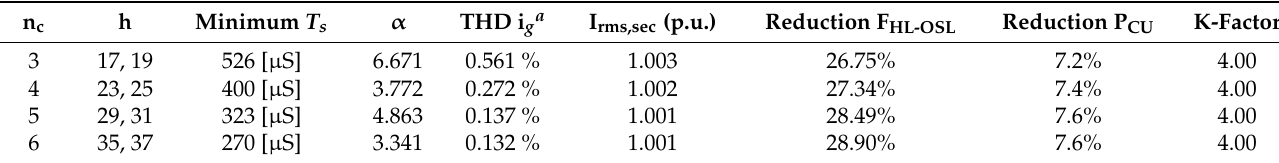
Table 3. Comparison between different number of